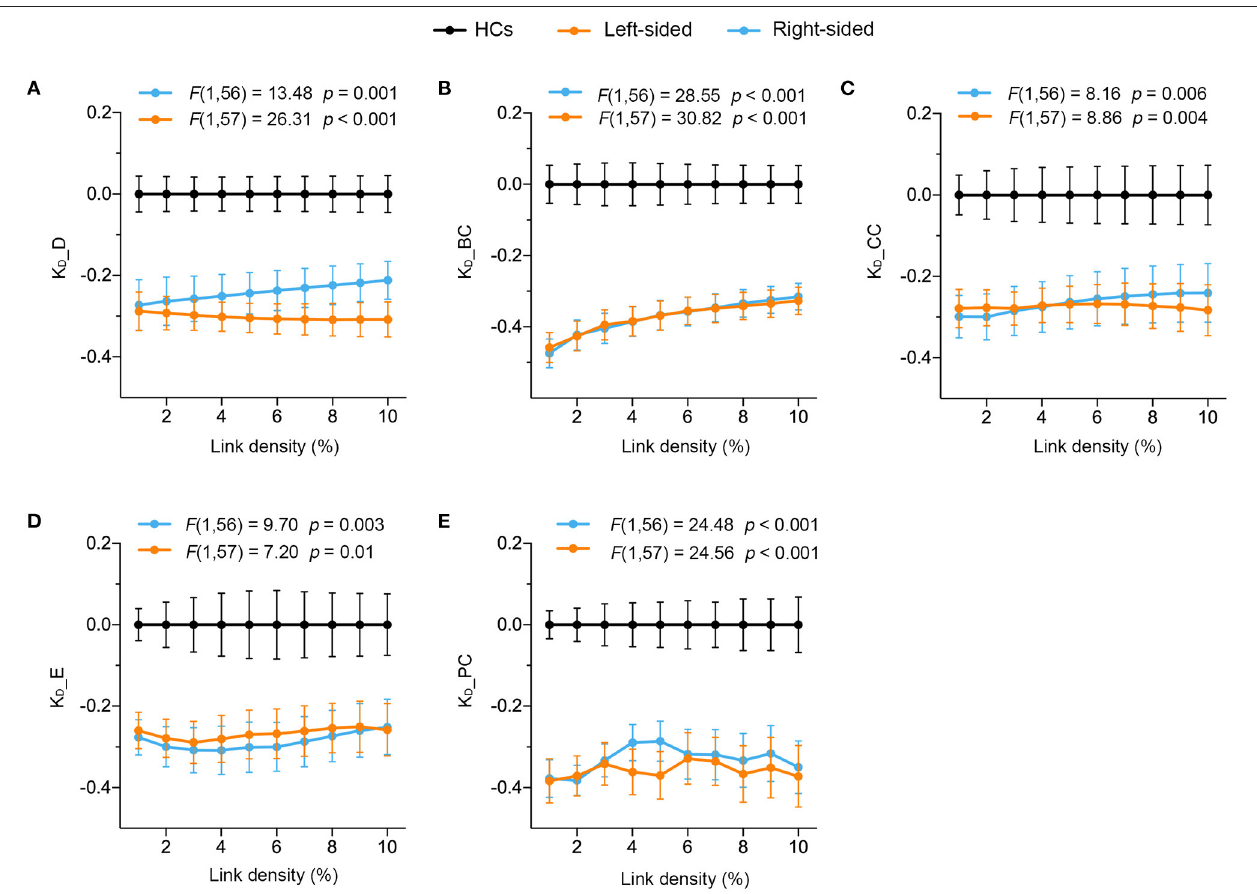
FIGURE 1 | Significantly altered global connectivity was observed in left- and right-sided stroke patients. A repeated measure ANCOVA with age and gender as covariates of no interest determined that (A) K D _D [ F (1,57) = 26.31, p < 0.001], (B) K D _BC [ F (1,57) = 30.82, p < 0.001], (C) K D _CC [ F (1,57) = 8.86, p = 0.004], (D) K D _E [ F (1,57) = 7.20, p = 0.01] and (E) K D _PC [ F (1,57) = 24.56, p < 0.001] of left-sided stroke patients (orange) and (A) K D _D [ F (1,56) = 13.48, p = 0.001], (B) K D _BC [ F (1,56) = 28.55, p < 0.001], (C) K D _CC [F (1,56) = 8.16, p = 0.006], (D) K D _E [ F (1,56) = 9.70, p = 0.003] and (E) K D _PC [ F (1,56) = 24.48, p < 0.001] of right-sided stroke patients (cyan) significantly decreased compared to HCs across all link densities. Data plotted as mean ± SE.